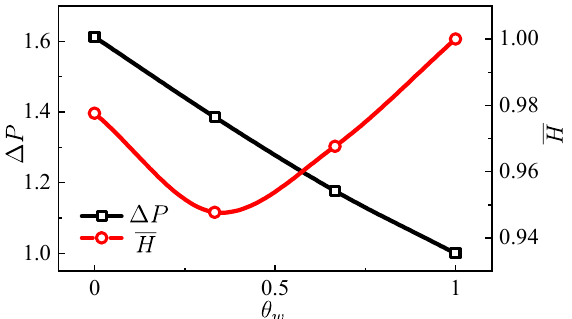
Figure 8. The dimensionless pressure drop ( ∆ P ) and cross-section mean apparent viscosity ( H ) at di ff erent temperatures. The pressure drop and the mean outlet apparent viscosity when θ w = 1 and Re gen = 2.3 × 10 − 2 are used as reference